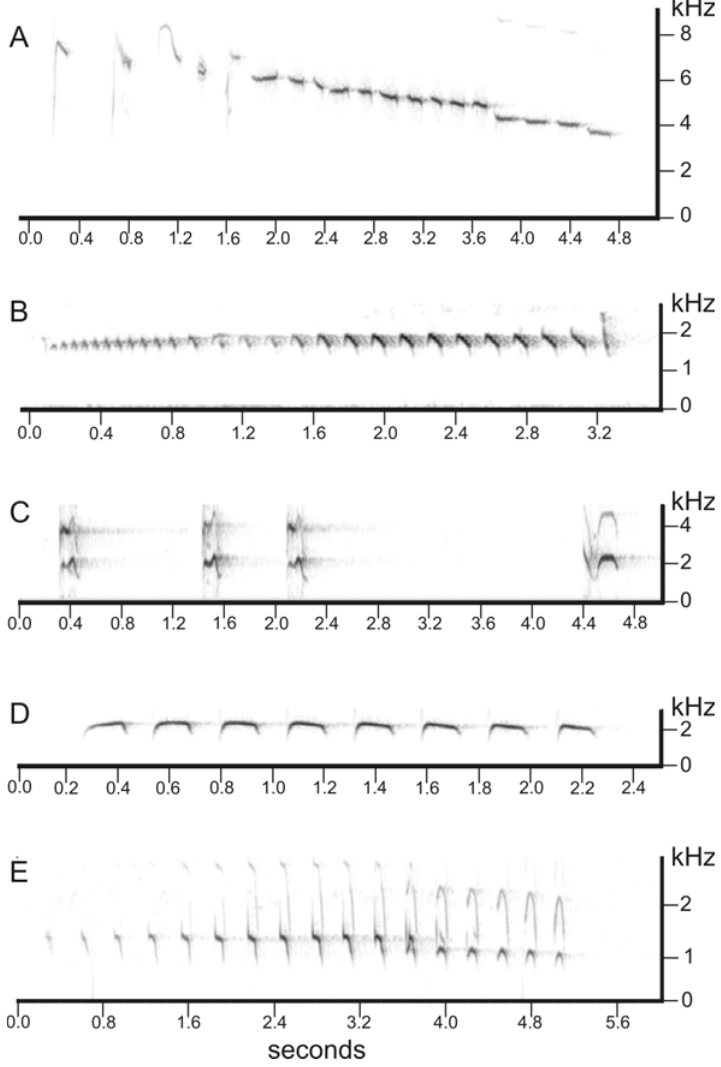
Fig. 1– Sonogramsofthevocalizationsusedforeachstudiedspeciesfortheplaybacksurveys. A : B. leucoblepharus ; B : B. cinerea ; C : C. caudata ; D : P. leucoptera ; E : T. surrucura . Each sonogram is presented in a distinct scale of time (in seconds) and frequency (in kHz). Extracted from the Arquivo Sonoro Neotropical (ASN),